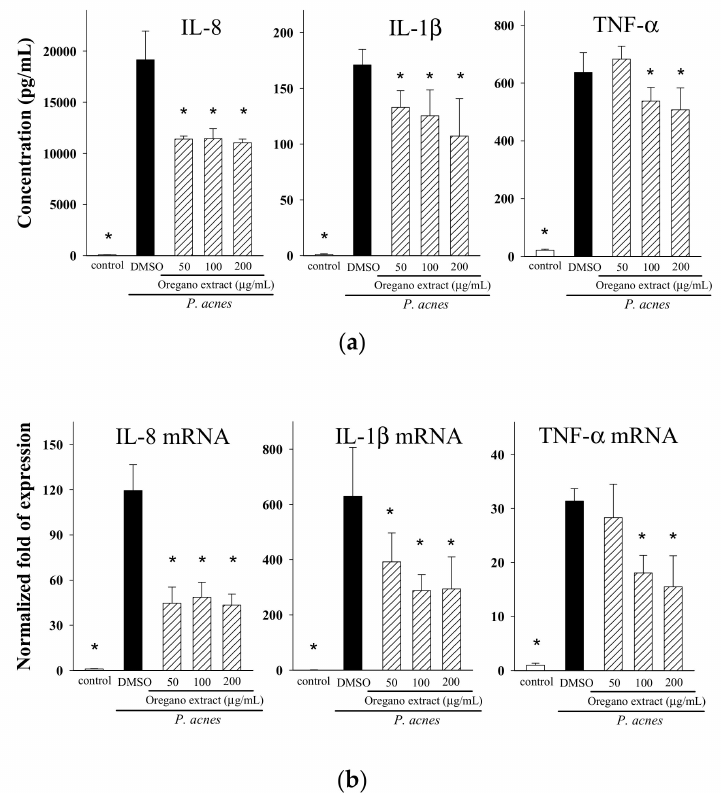
Figure 3. Effects of various concentrations of EOE supplementation on cytokine secretion and mRNA level. Interleukin (IL)-8, IL-1 β , and tumor necrosis factor (TNF)- α concentrations ( a ), and their mRNA levels ( b ) by P. acnes -stimulated THP-1 cells. Cells were co-cultured with P. acnes (200 µ g/mL) and different concentrations (50, 100 or 200 µ g/mL) of EOE for 24 h. The levels of cytokine mRNA were normalized to glyceraldehydes 3-phosphate dehydrogenase (GAPDH) mRNA and expressed as multiples of change with the control (untreated THP-1 cells). The bars indicate the mean ± SD of three independent experiments. The values with a symbol (*) are significantly different from the DMSO (vehicle) group at p <